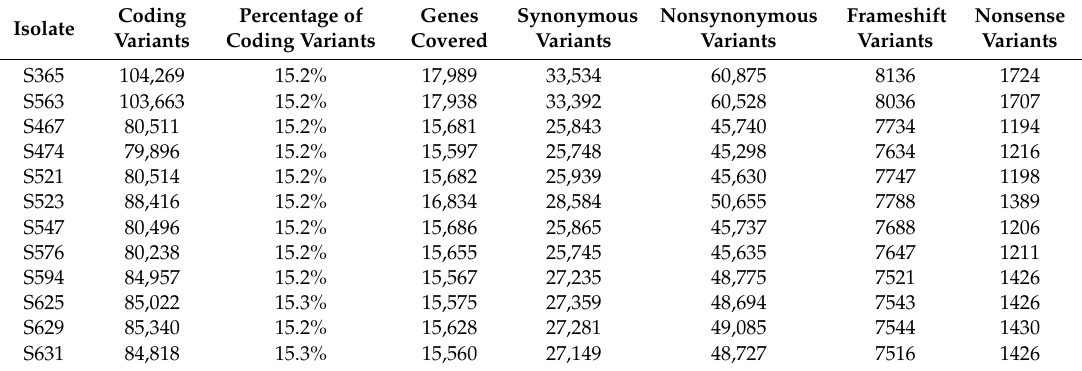
Table 3. Summary of the functional impacts of small genomic variants in the 12 Pt